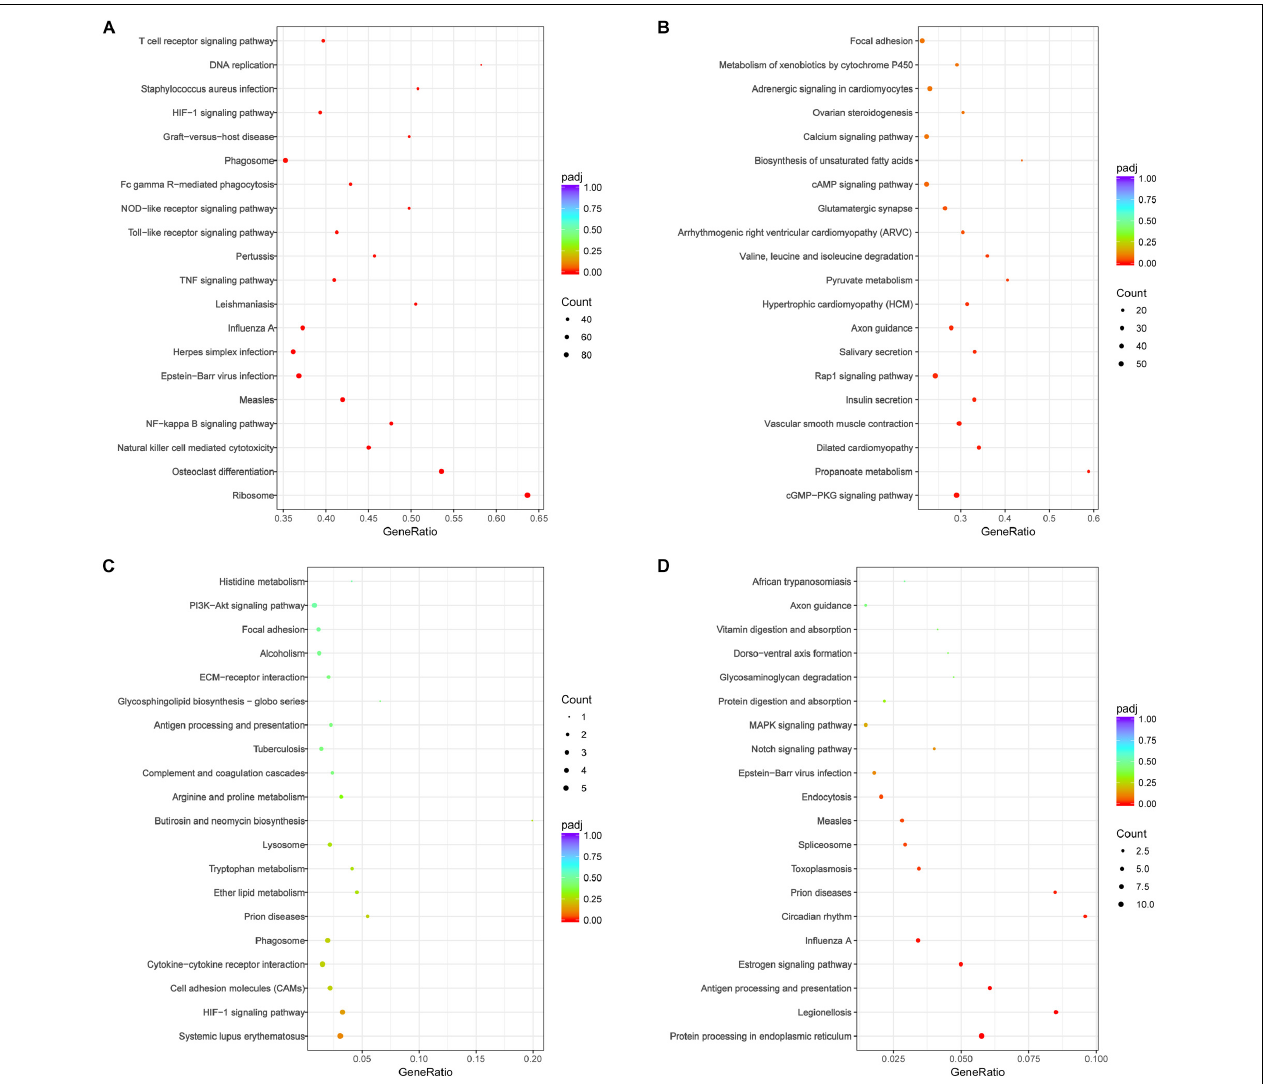
FIGURE 8 | KEGG pathway analysis of DEGs following H1N1 infection revealed significant pathways ( p adj < 0.05) involved in local immune responses and cell adhesion molecules in the lung of mice on (A,B) 7 and (C,D) 28 dpi. (A) The enrichment pathways of up-regulated genes at 7 dpi; (B) the enrichment pathways of the down-regulated genes at 7 dpi; (C) the enrichment pathways of up-regulated genes at 28 dpi; (D) the enrichment pathways of down-regulated genes at 28 dpi. The size of the circle indicated the number of the genes. The color of the circle indicated Q value. Gene Ratio refers the ratio of Sample number and Background number enriched in the pathway. The value range of adjusted P -value ( p adj) is [0,1], and the closer to zero, the enrichment is more